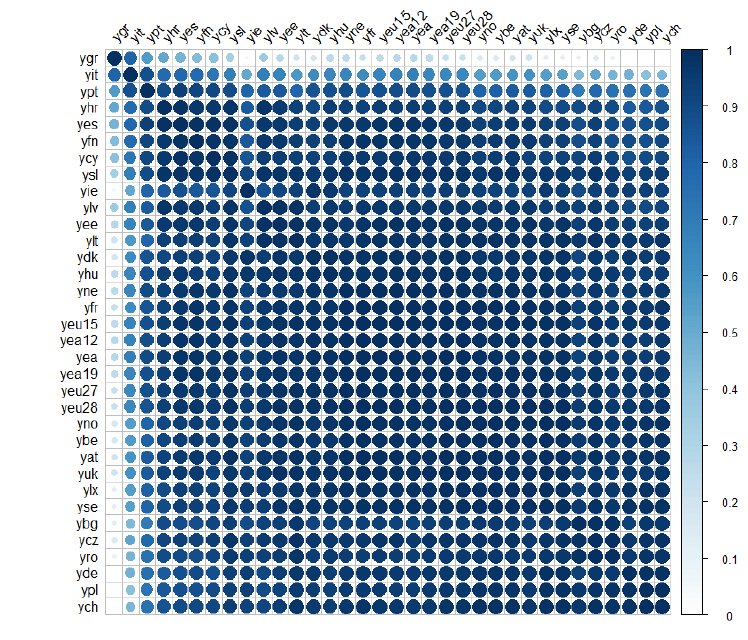
Figure 3. Heat map matrix of Pearson correlation coefficients between output growth rates for all the entities in the sample. Source: own elaboration with data from Eurostat. Note: the labels denominate the output (y) plus the two-letter country codes (e.g. at – Austria).